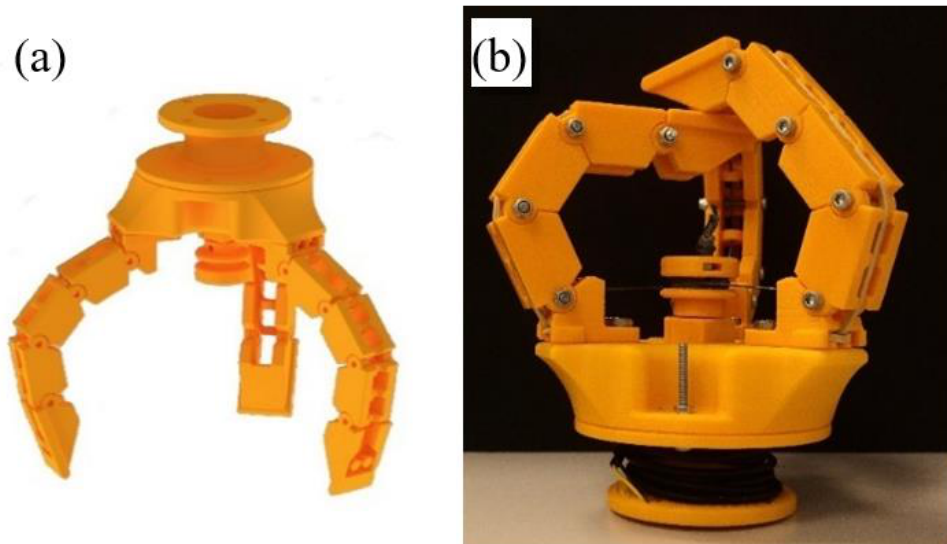
Figure 6. Third gripper: ( a ) CAD model of the gripper, ( b ) Real Gripper. The shape that fingers adopt is a function of the object to be grasped; the links of the finger will adapt to the outer surface of the